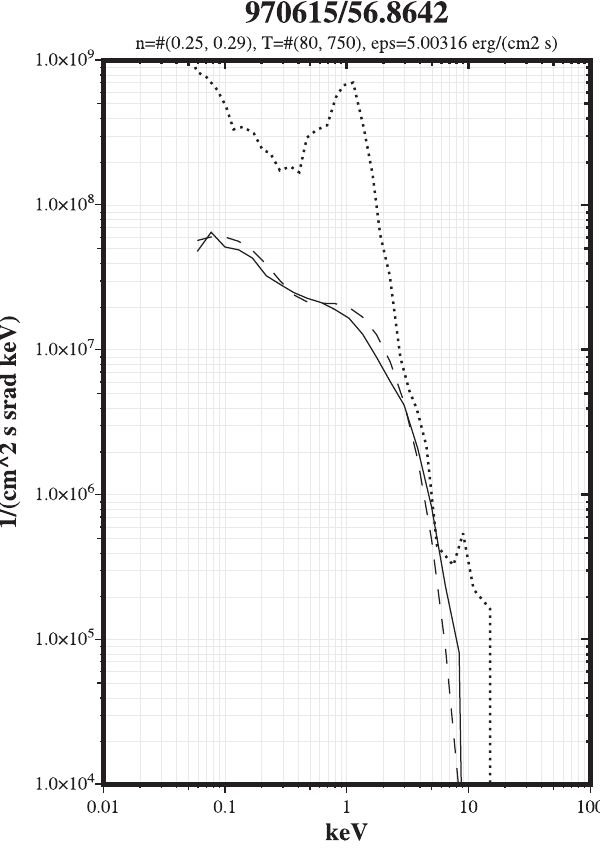
Fig. 6. The single-Maxwellian data example. The dotted line is the measured FAST electron flux. The particles on the left of the peak at 1 kV are secondaries which are not relevant to the modeling in this study. The secondary peak at 9 kV is not a recurrent phenomenon in the data and can be ignored. The solid line is a HYDRA particle flux which is approximately in conjunction with the FAST electron spectrum. The dashed line is the result of summing up two Maxwellian populations with densities of 0.25 and 0 : 29cm (cid:255) 3 and temperatures of 80 and 750 eV, respectively